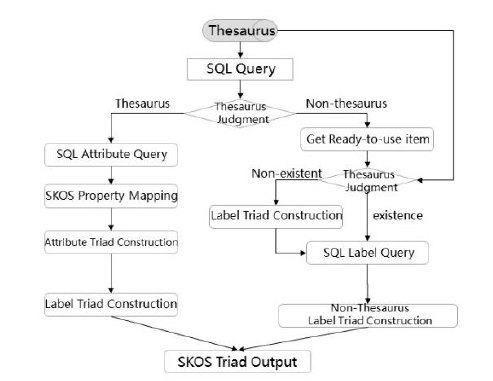
Figure 3 . SKOS conversion technology flow